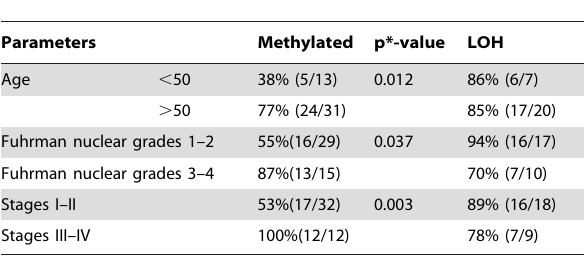
Table 2. Association of clinical-pathological characteristics and hypermethylation/LOH status of the WNT7A gene in clear cell RCCs.